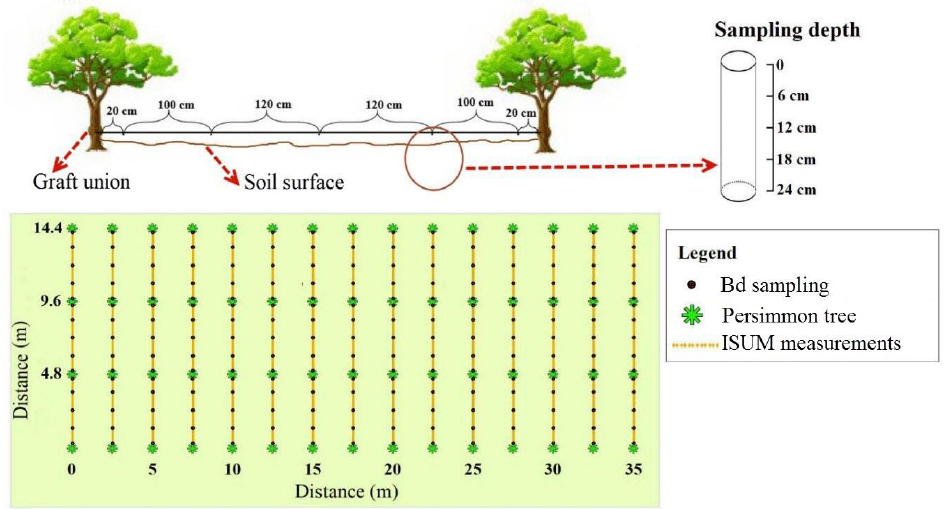
Figure 2. Cross-section and vertical view of improved stock unearthing method (ISUM) and core method sampling strategies. Bd: Bulk density.